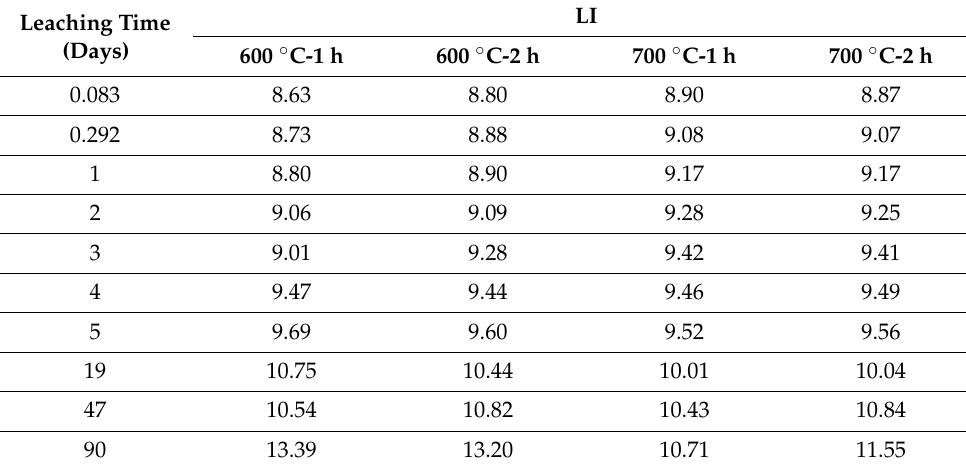
Table 6. Leachability Index of Cs from cylindrical